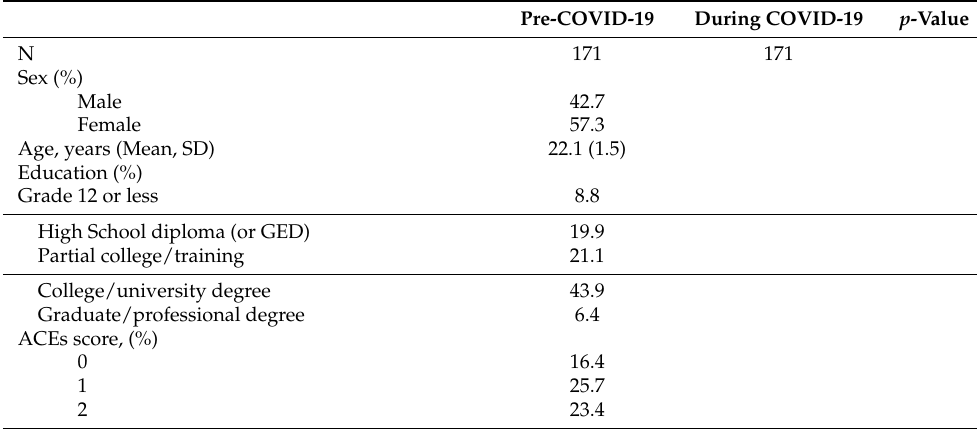
Table 1. Descriptive statistics of all measures 1